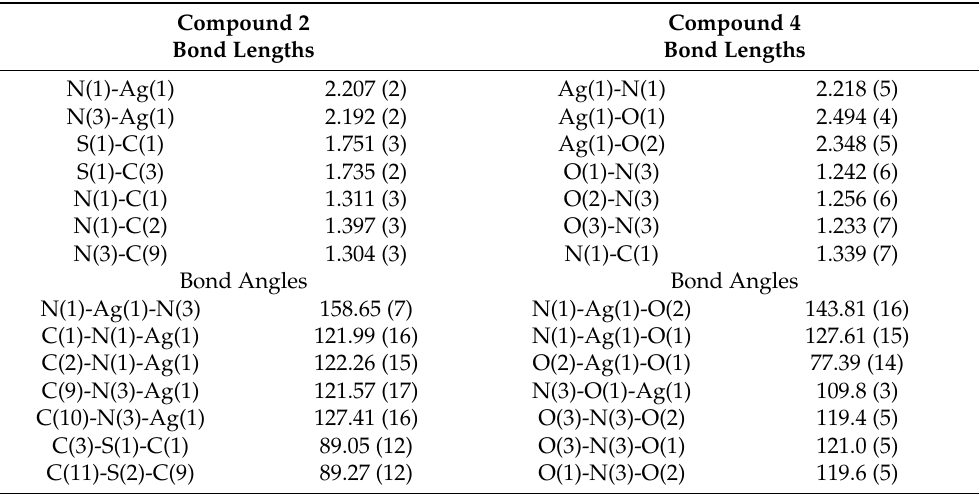
Table 3. Summarized structural parameters, bond angles ( ◦ ) and bond lengths (Å) for compounds 2 and 4